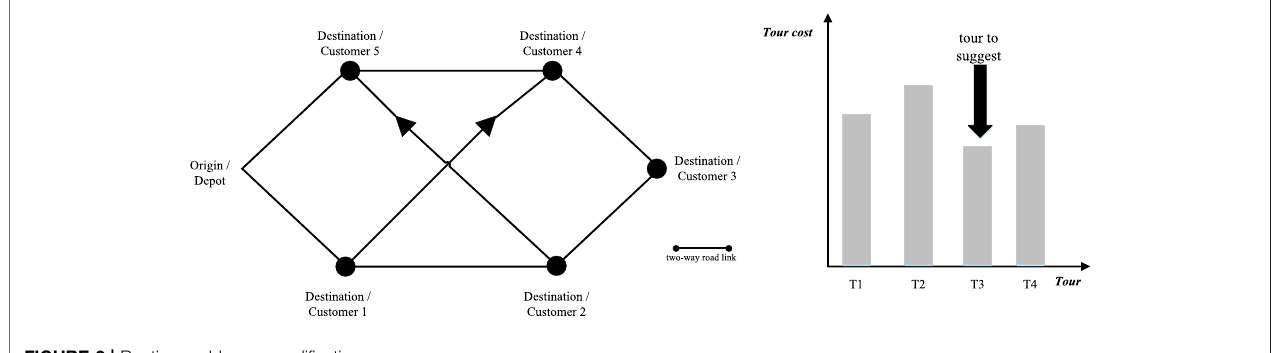
FIGURE 2 | Routing problem exempli fi